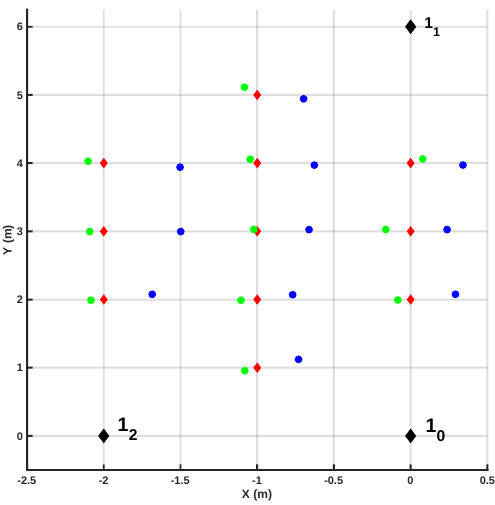
Figure 11. TSLS correction for static measurements, Anchor 2 in